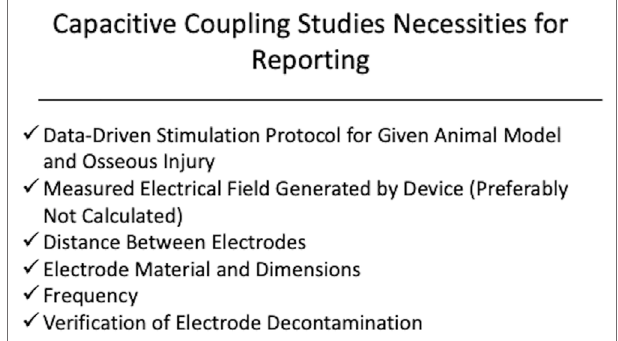
FIGURE 2 | Displayed is a schematic of the recommended components of device speci fi cations and stimulation protocol for capacitive coupling. The authors recommend reporting a measured electric fi eld strength, frequency, distance between electrodes, electrode material, and veri fi cation of electrode decontamination. It is also recommended that the stimulation protocol be derived from previous studies demonstrating bene fi t of the ES modality within the context of the osseous injury being studied.